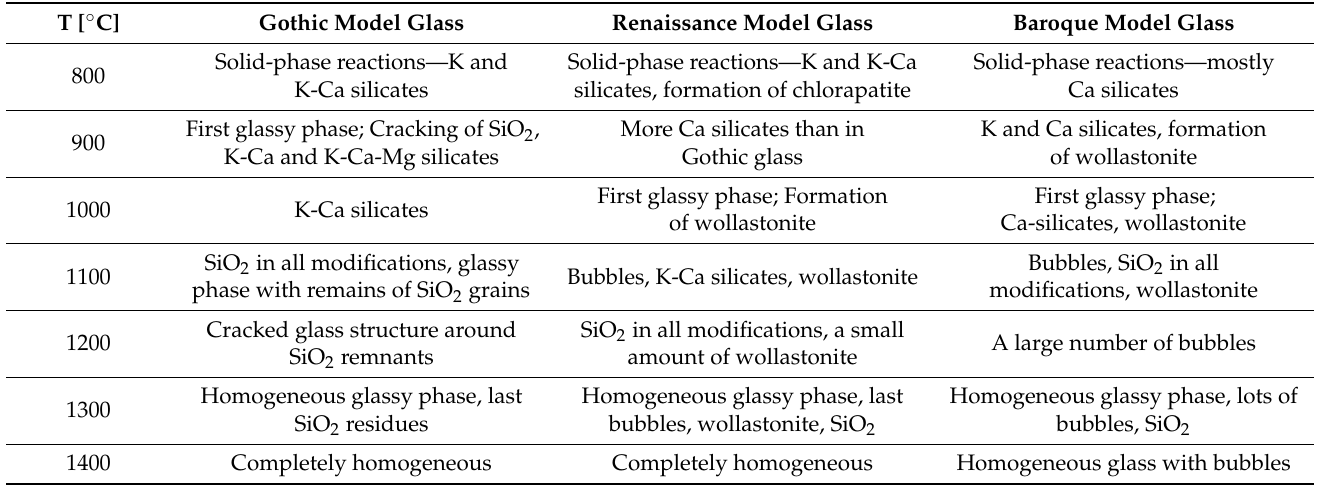
Table 4. Overview of the most important changes in phase composition and homogeneity during melting of model glasses.